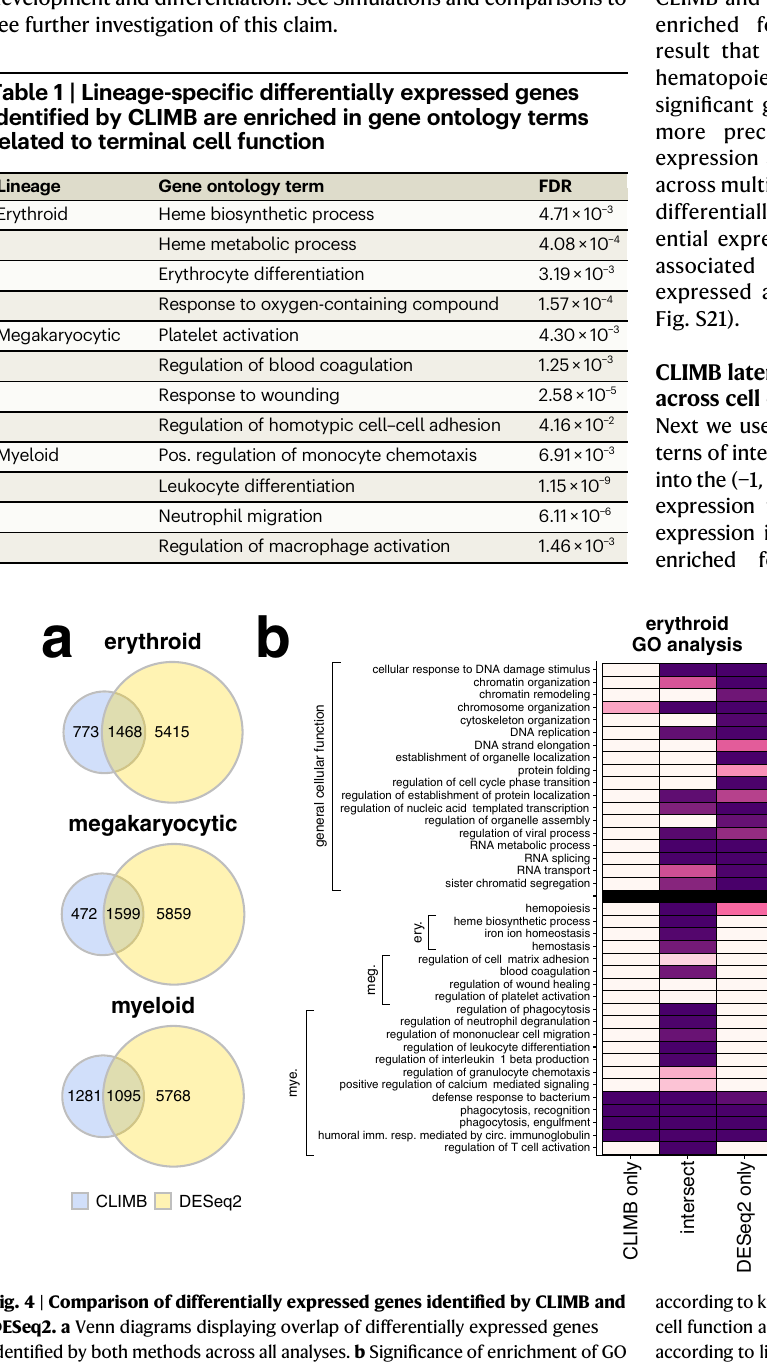
accordingtoknowledge-drivenlabels.Non-hematopoietictermsrelatedtogeneral cell function are above the black line. Hematopoietic-related terms, grouped according to lineage-speci fi c function, are below the black